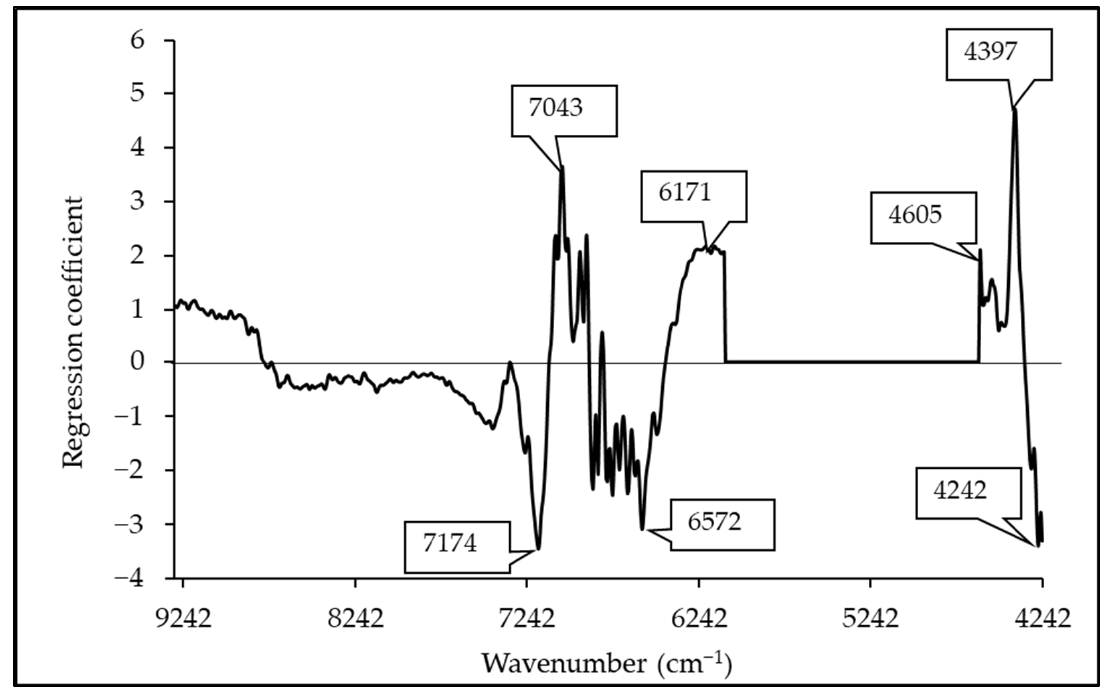
Figure 8. Regression coefficient plot of the PLSR model for TSS in mangosteen purée.